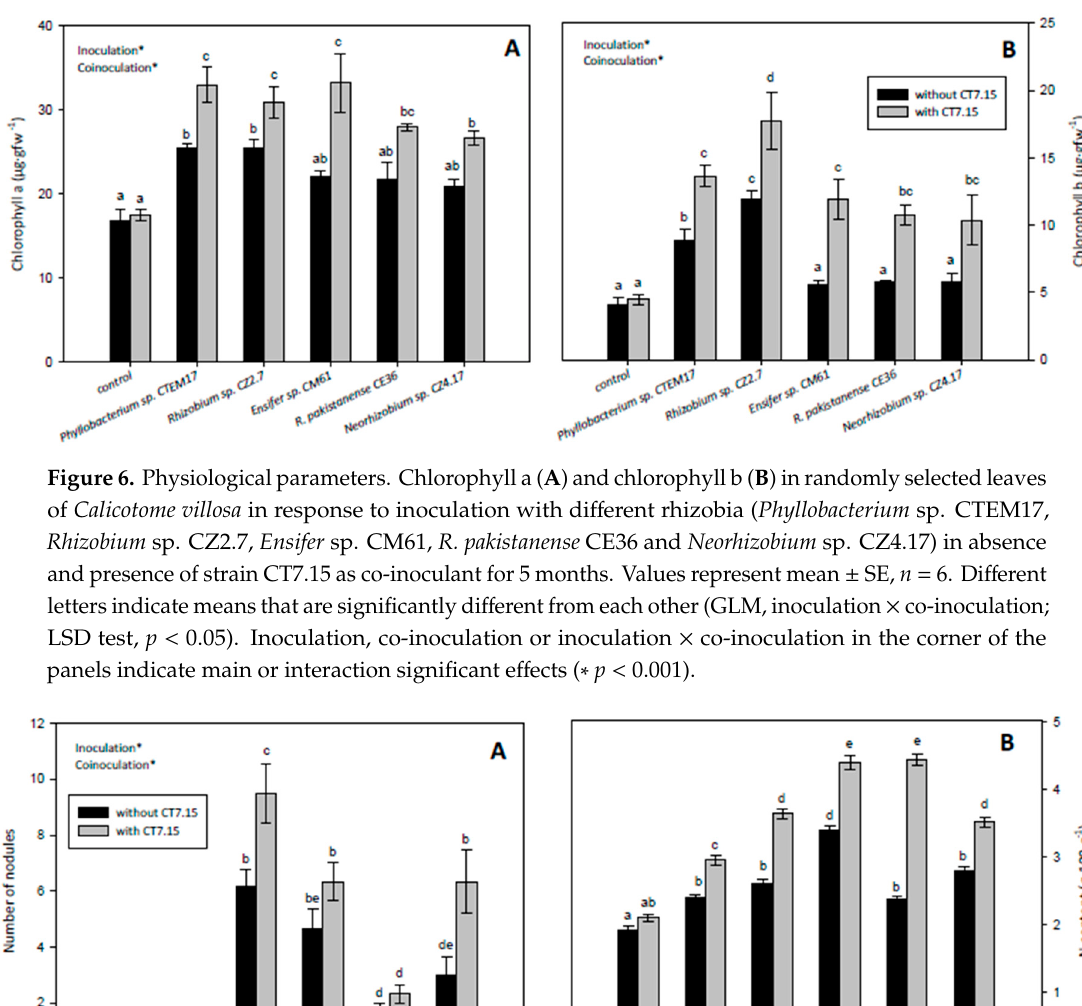
11 of 16 Figure 5. Aerial part dry weight ( A ), root dry weight ( B ) and plant height ( C ) of Calicotome villosa in response to inoculation with different rhizobia ( Phyllobacterium sp. CTEM17, Rhizobium sp. CZ2.7, Ensifer sp. CM61, R. pakistanense CE36 and Neorhizobium sp. CZ4.17) in absence and presence of strain CT7.15 as co-inoculant for 5 months. Values represent mean ± SE, n = 6. Different letters indicate means that are significantly different from each other (GLM, inoculation × co-inoculation; LSD test, p < 0.05). Inoculation, co-inoculation or inoculation × co-inoculation in the corner of the panels indicate main or interaction significant effects ( ∗ p < 0.001). The effect of plant inoculation either with rhizobia or co-inoculation with CT7.15 on chlorophyll concentrations was also recorded (Figure 6). Inoculation with rhizobia increased chlorophyll a and b concentrations compared to control plants, with their values being significantly higher in plants